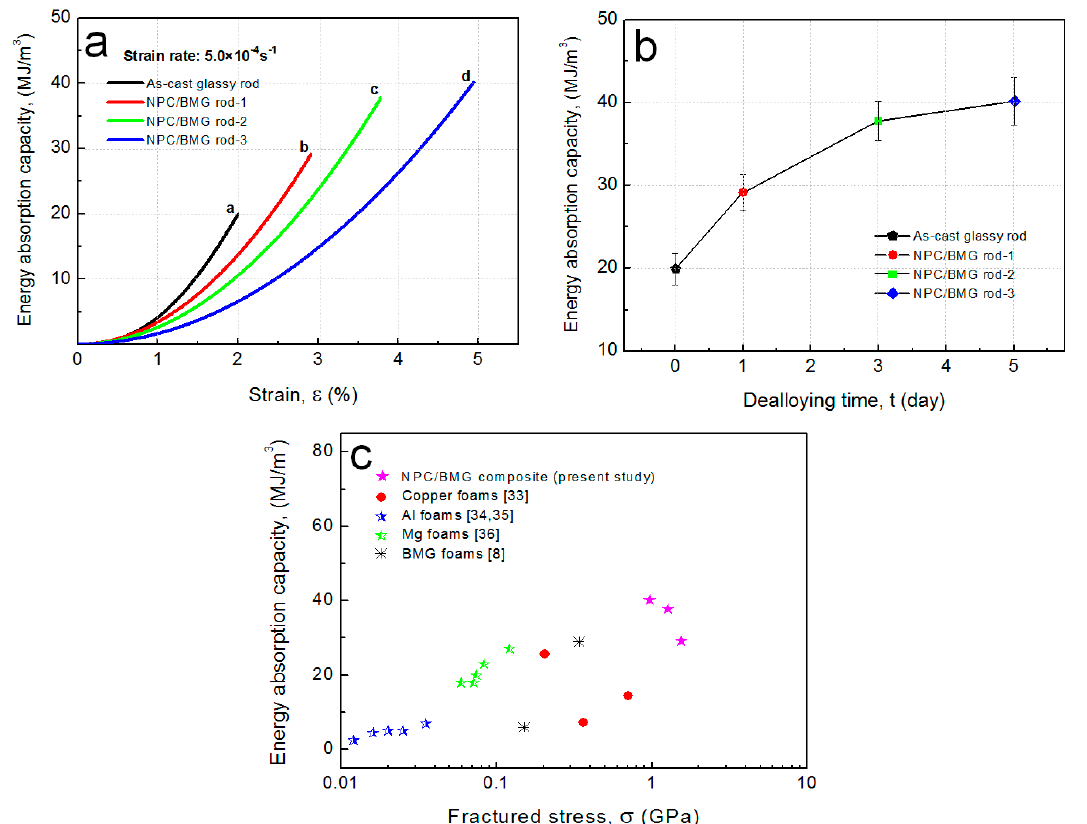
Figure 6. ( a ) Energy absorption capacity of the as-cast Cu 50 Zr 45 Al 5 BMG rod and the NPC/BMG composite rods; ( b ) Changes in the energy absorption capacity of composite rods with dealloying time; ( c ) The comparison of energy absorption capacity (EAC) for NPC/BMG composite rods and other alloy foams.